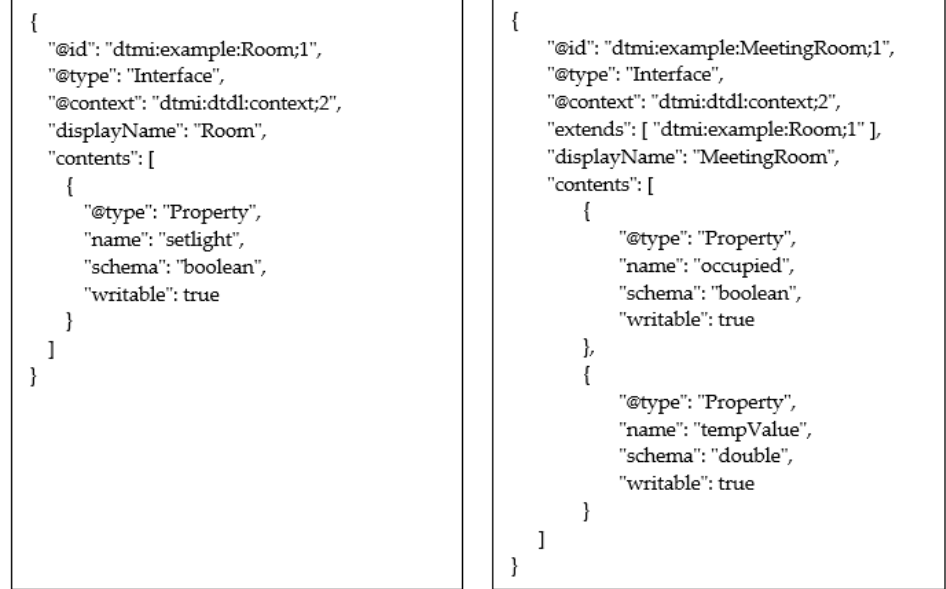
Figure 11. Example of the DTDL Interface: model of a Room ( left ) and model of a MeetingRoom ( right ).